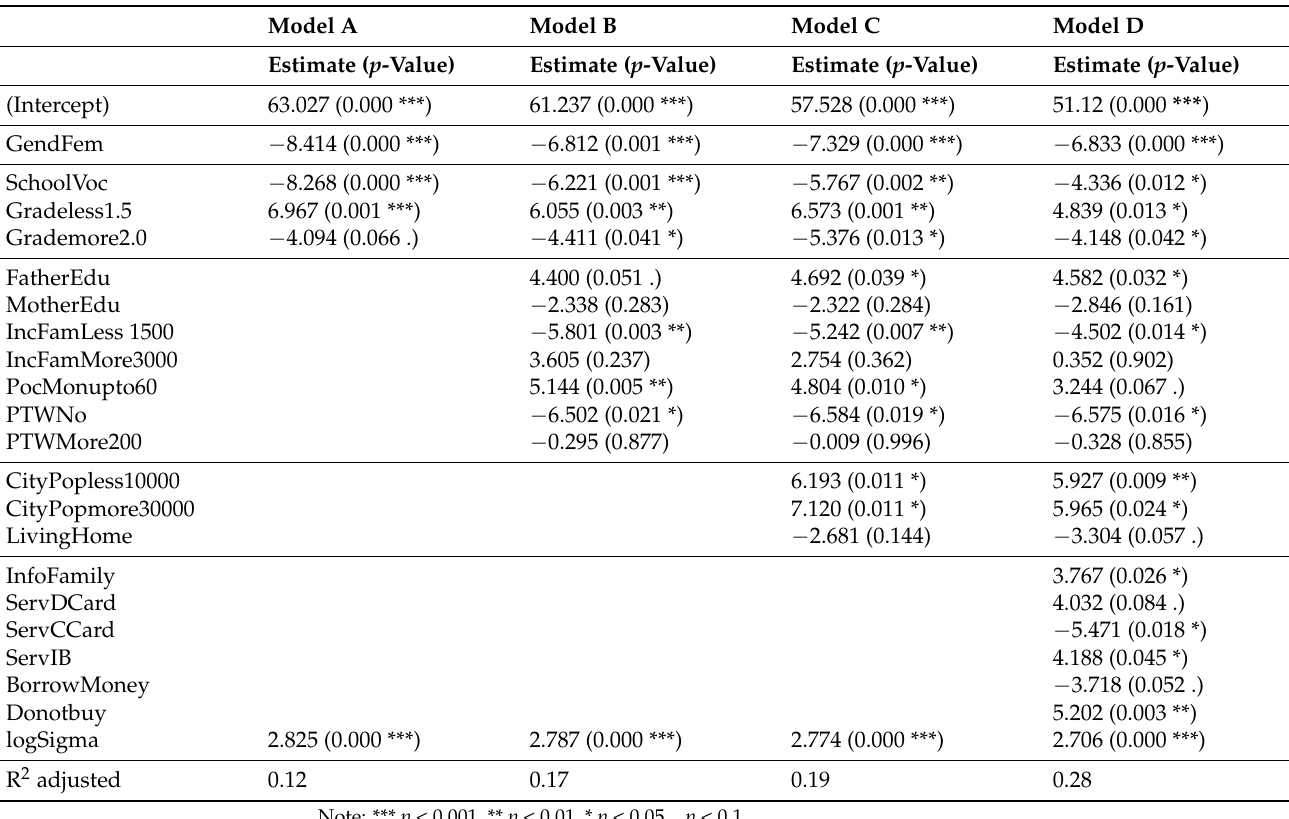
Table 6. OLS Regression Analysis Results: Models A–D.